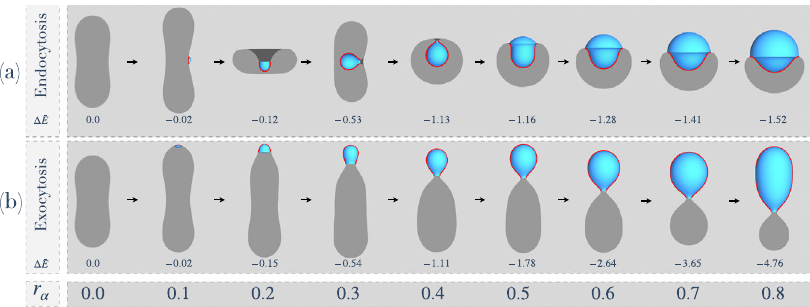
Fig. 1 Nanodroplet-vesicle morphology for nanodroplets with different radii. Panels ( a ) and ( b ) show the cutaway views of the nanodroplet-vesicle system for different sizes of endocytic and exocytic nanodroplets, respectively. The wetting energy values Δ E are listed below for each shape. The vesicle surface is shown in gray, the nanodroplet in light blue, and the αγ segment of the membrane, where the membrane is in contact with both α and γ phases, is highlighted with red color. The nanodroplet size increases from left to right. The vesicle radius is R ve = 1 μ m, the vesicle volume-to-area ratio is v = 0.7, and the relative size of nanodroplet to vesicle is denoted by r α = R α /R ve , where R α is the nanodroplet radius and R ve is the vesicle size. The bending rigidity of the vesicle is κ = 20 k B T , and the interfacial tension of the nanodroplet is Σ αβ = 5 μ Nm −